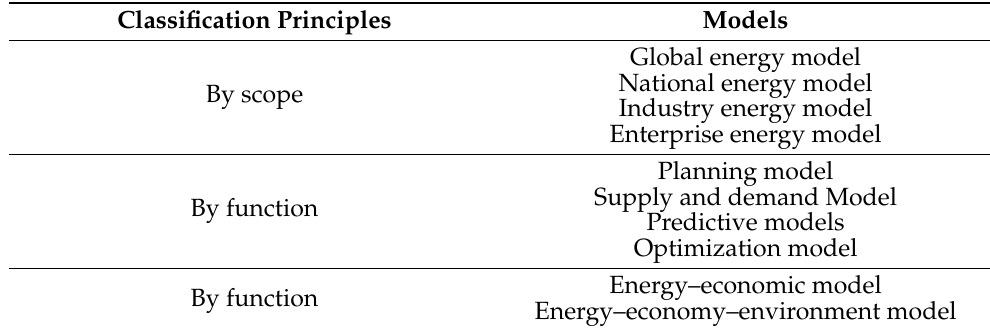
Table 1: Any system has its hierarchy, and energy systems are no exception.